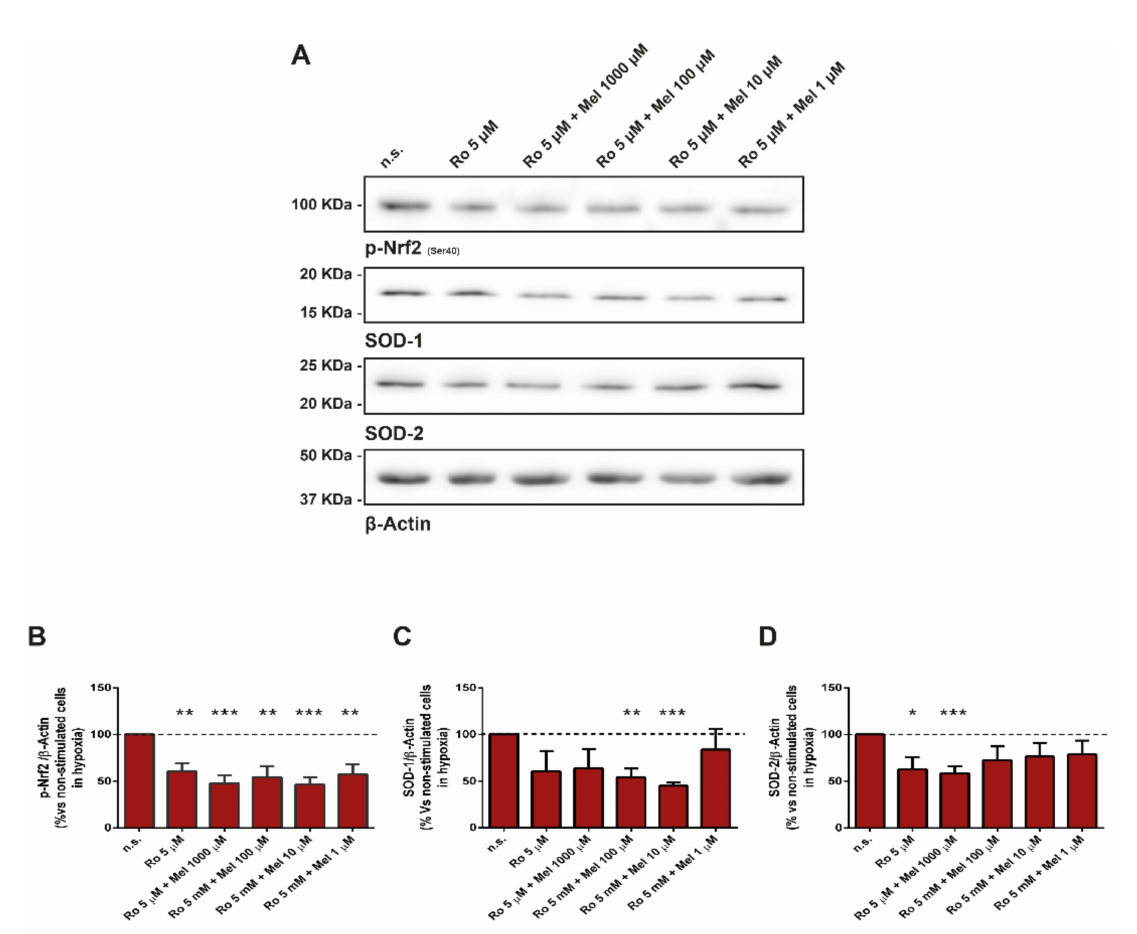
Figure 5. Effect of PKC inhibition on melatonin-evoked changes in Nrf2 and SOD. PSCs were incubated during 5 min in the presence of the PKC inhibitor Ro-31-8220 (5 µ M) under hypoxia. Thereafter, melatonin (1000 µ M, 100 µ M, 10 µ M, or 1 µ M) was added to the incubation medium and cells were incubated for further 4 h under hypoxia. ( A ) Western blotting analysis was carried out to detect the phosphorylation of Nrf2 and the expression of SOD1 and SOD2 in cells treated with the PKC inhibitor. The levels of β -actin were employed as controls to ensure equal loading of proteins. The blots show the effect of melatonin on protein expression. ( B – D ) The graphs show the quantification of Nrf2 phosphorylation and of SOD1 and SOD2 expression. A horizontal dashed line represents the value observed in non-treated cells (incubated in the absence of melatonin). Values are the mean ± S.E.M. of normalized values expressed as % with respect to non-treated cells. Results are representative of four independent experiments (n.s., non-treated cells; Mel, melatonin; Ro, Ro-31-8220; *, p < 0.05; **, p < 0.01; and ***, p < 0.001 vs. non-treated cells in